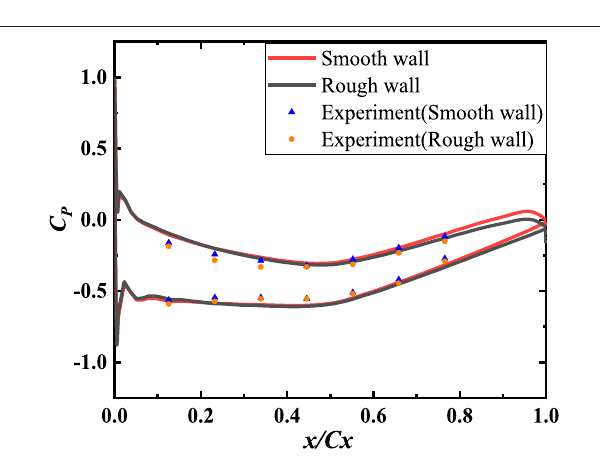
FIGURE 5 | Comparison of experimental and numerical simulation